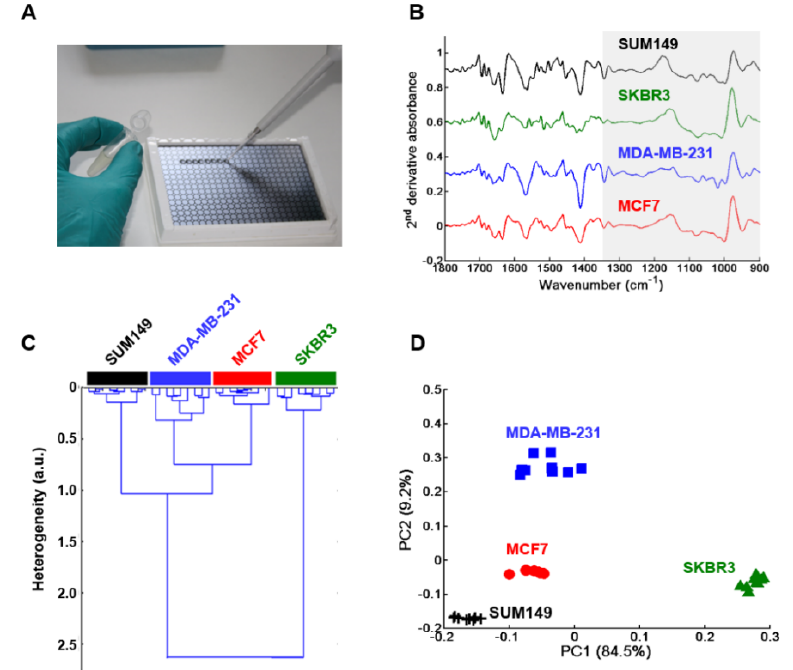
Figure 1. High-throughput Fourier Transform InfraRed (FTIR) spectroscopy of GAGs extracted from conditioned media (secretome) of MCF7, MDA-MB-231, SKBR3 and SUM149 cells. ( A ) Photograph of a silicon plate with sample deposits; ( B ) Comparison between normalized mean second derivative spectra of conditioned media (CM) from the four cell lines. Spectra are offset for clarity; ( C ) HCA analysis and ( D ) PCA score plot of MCF7 (full red circles), MDA-MB-231 (full blue squares), SKBR3 (full green triangles), and SUM149 (black crosses). Both analyses were performed on normalized mean second derivative spectra using the frequency range 1350–900 cm − 1 .